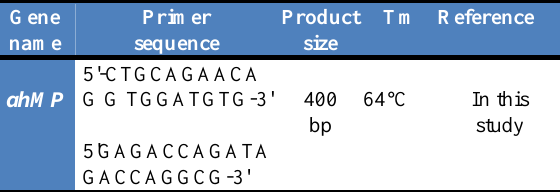
Table, 1: PCR oligonucleotide